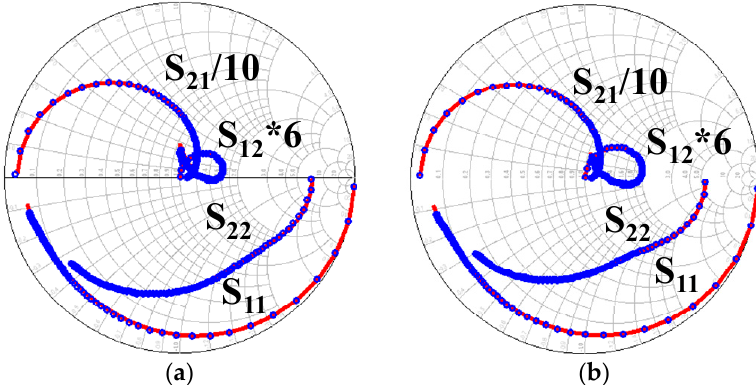
Figure 5. Small signal characteristic validation of the proposed model at different bias points: ( a ) V gs = − 2.2 V, V ds = 20 V and ( b ) V gs = − 2.6 V, V ds = 28 V.